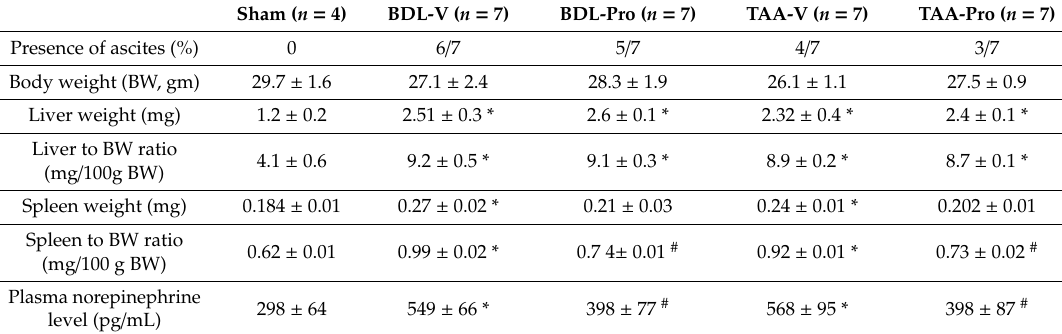
Table 2. Basal characteristics of all